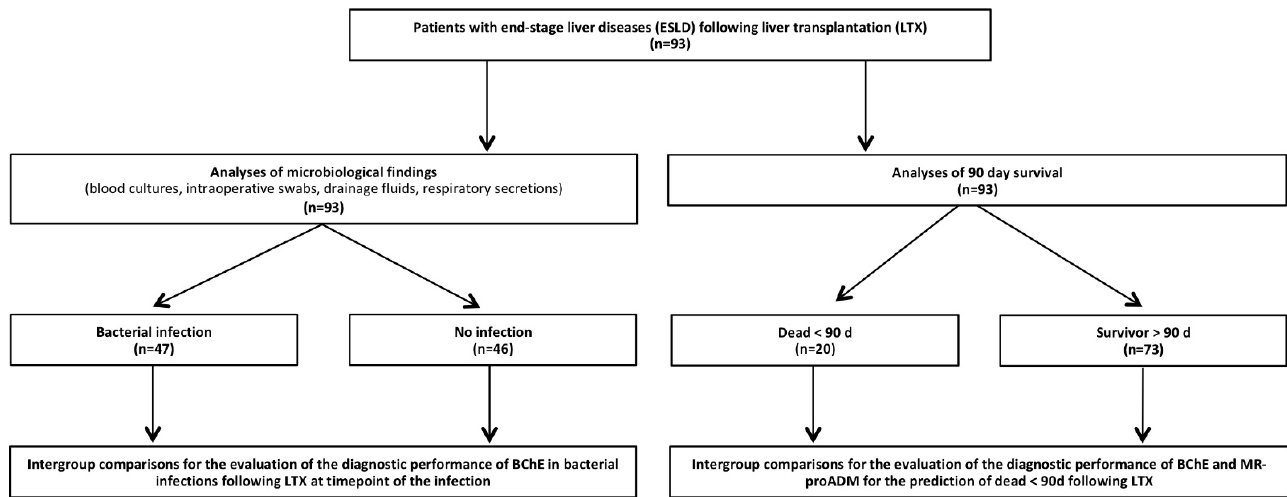
Figure 1. Flowchart of included patients. Abbreviations: ESLD, end-stage liver disease; LTX, liver transplantation, BChE, butyrylcholinesterase; MR-proADM, mid-regional proadrenomedullin.